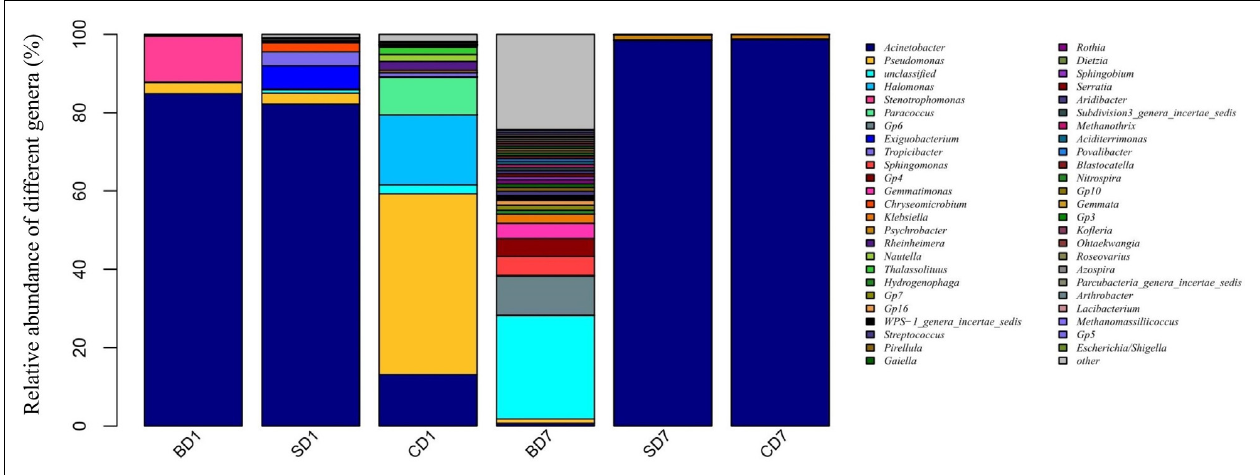
FIGURE 2 | Relative abundance of different bacterial genera within PL microbiota in BD, SD, and control (CD) groups. This distribution bar plot was drawn with R software. BD1, SD1, and CD1 represent PL samples at day 1 of the test, and BD7, SD7, and CD7 represent PL samples at day 7.